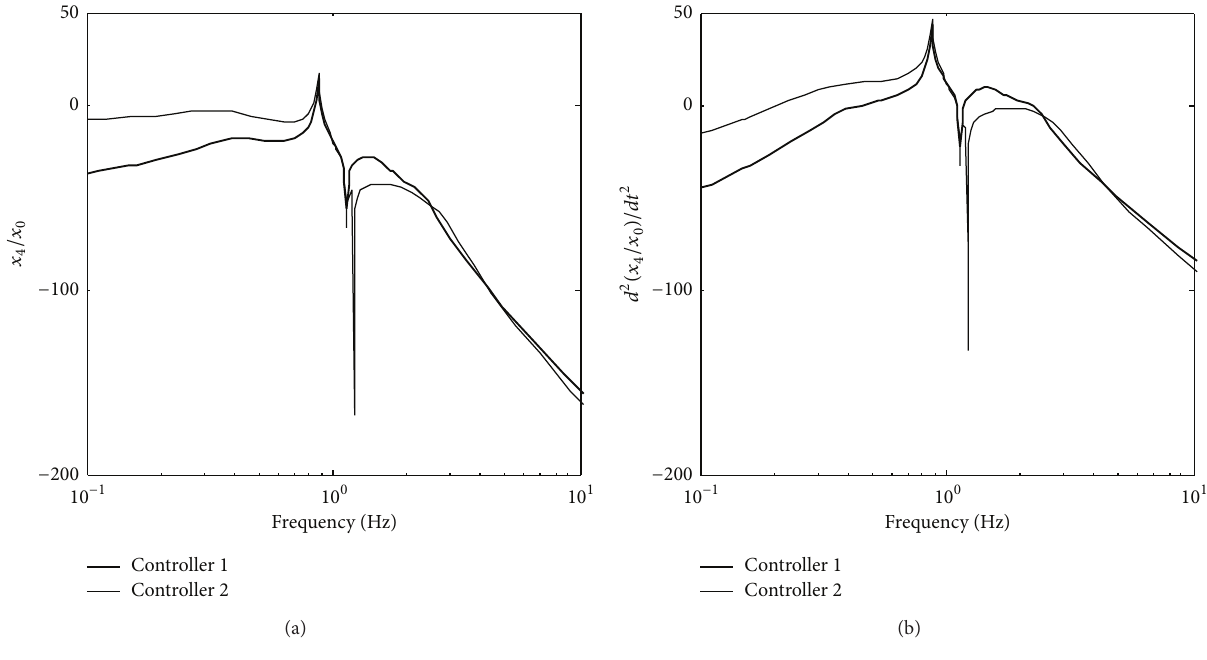
Figure 12: Comparison of frequency responses of the 𝑥 4